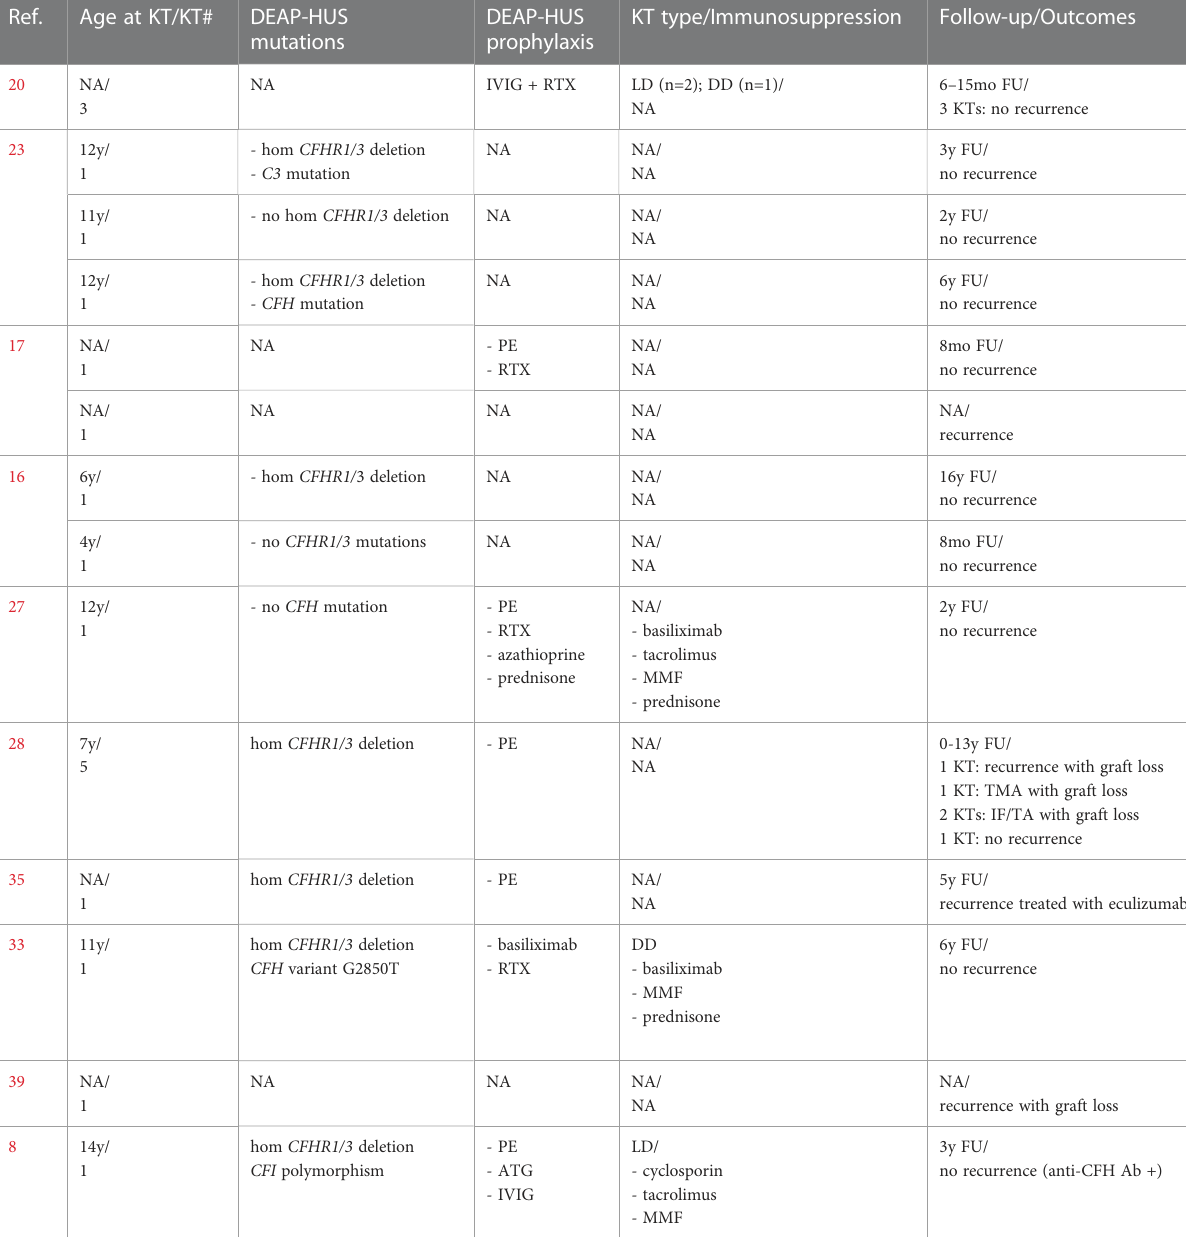
TABLE 1 Previously published reports of kidney transplantation in patients with DEAP-HUS.